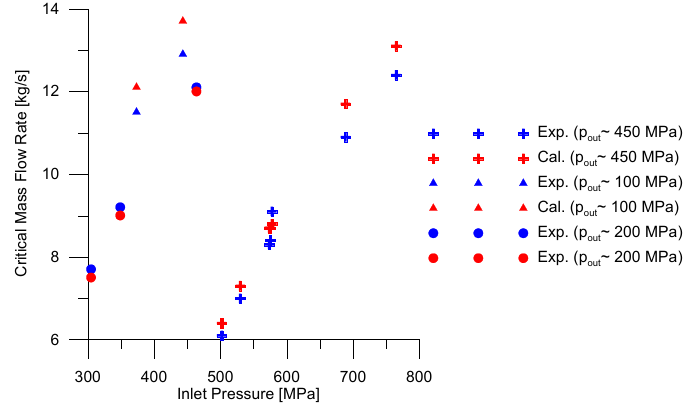
Figure 10. Dependence of the critical mass flow rate on inlet and outlet pressure in the nozzle.